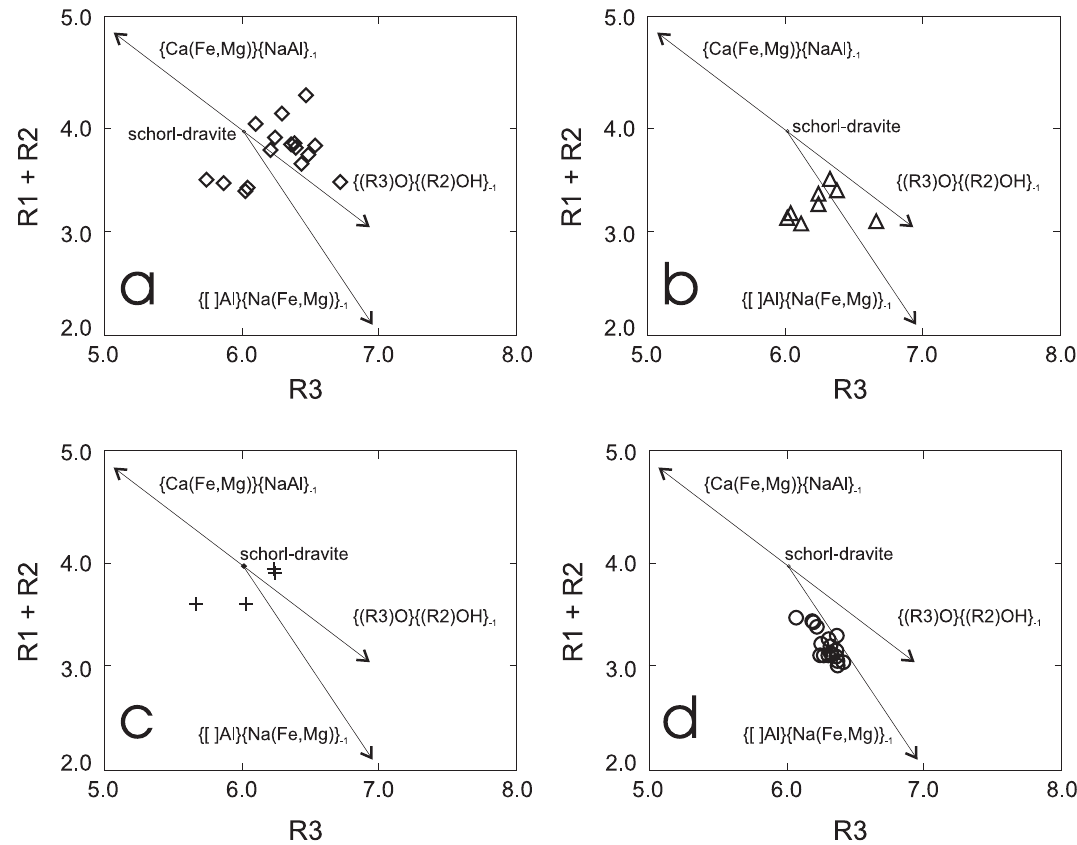
Fig. 5 – Representation of tourmaline compositions in the R1 + R2 vs. R3 diagram (R1, R2 and R3 calculated after Yavuz 1997). Tourmalines from: (a) metachert – Tapera Grande and Quartzito; (b) tourmalinite – Tapera Grande; (c) quartz vein – Tapera Grande, and (d) quartz vein –